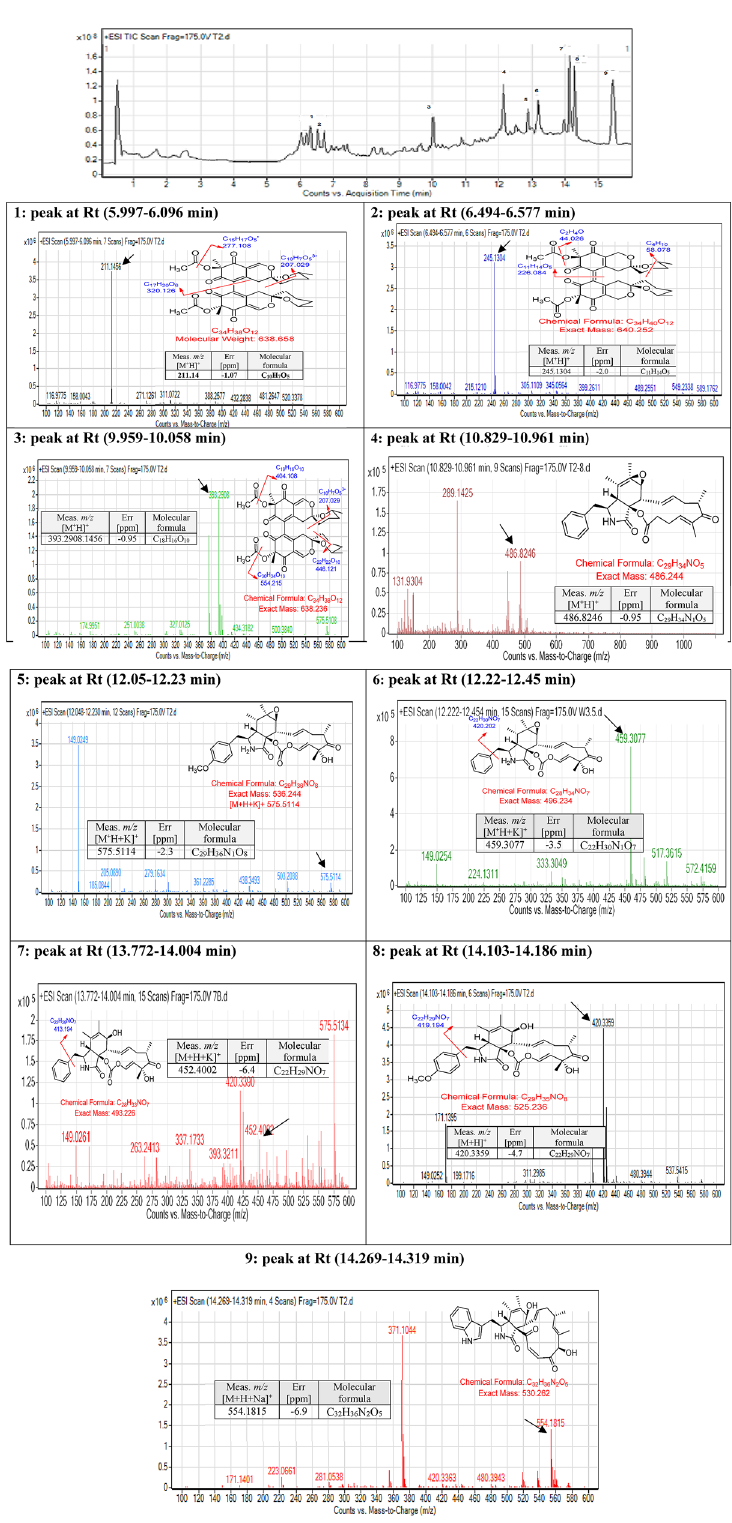
Figure 11. Base peak chromatogram of Chaetomium globosum crude extract and identified secondary metabolites which are: Cochliodone A (1), Cochliodone J (2), Cochliodone A (3), Rosellichalasin [2] (4), Cytochalasin B (5), Cytochalasin E (6), Cytochalasin K (7), Scoparasin A (8), Chaetoglobosin (9). Meas m/z implies measured